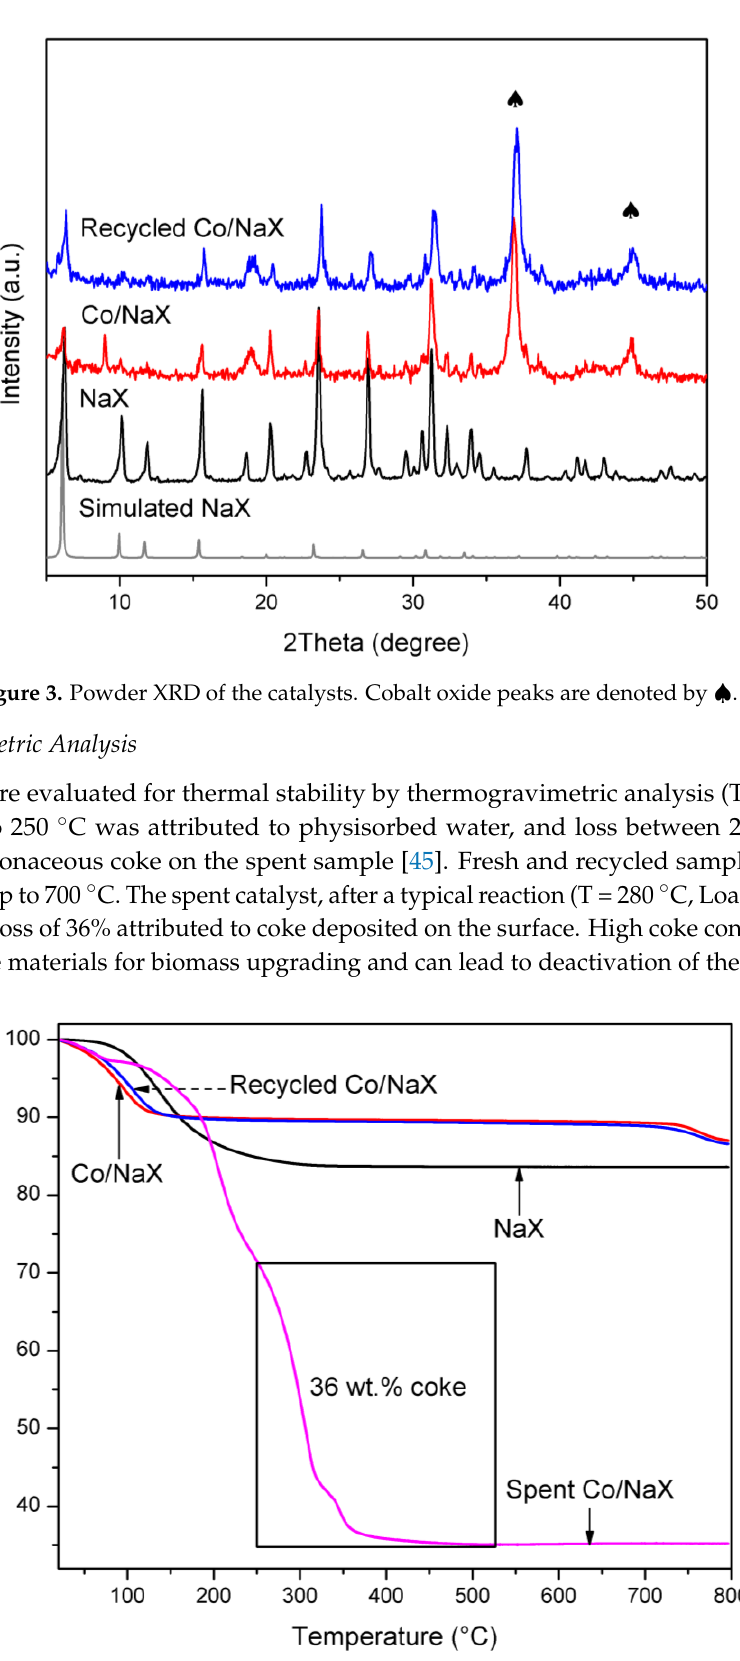
Figure 4. TGA of the spent catalyst shows a significant accumulation of coke.